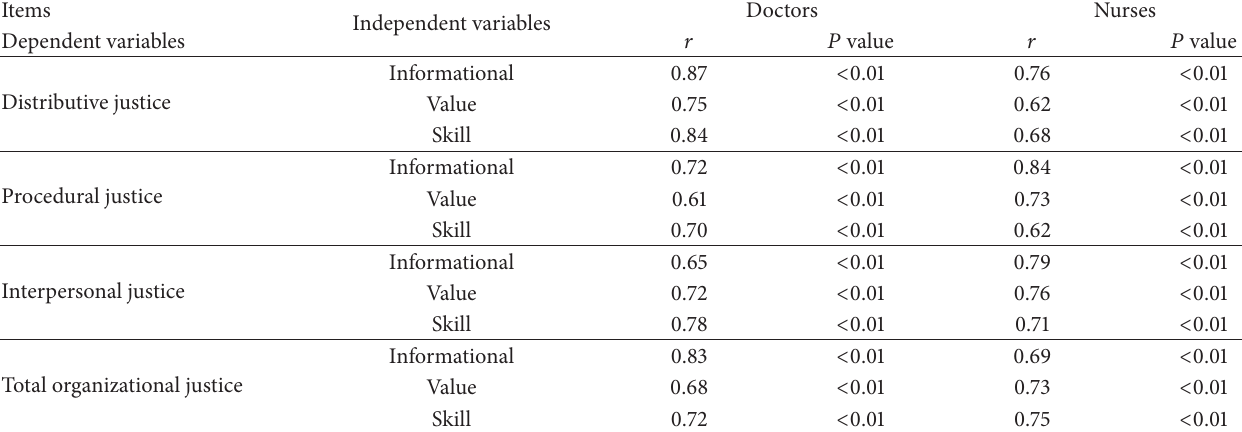
Table 3: The relation between organization justice and quality performance among healthcare workers categories ( 𝑛 = 100